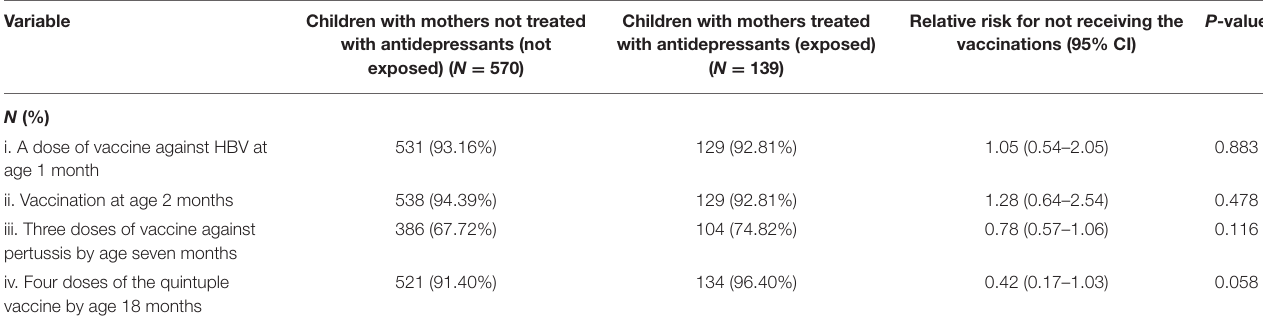
TABLE 4 | Relative risk values for non-vaccination of children whose mothers had pospartum depression symptoms who were treated with antidepressants in comparison with children whose mothers had postpartum depression symptoms who were not treated with antidepressants. P Relative risk for not receiving the Children with mothers treated Variable Children with mothers not treated vaccinations (95% CI) with antidepressants (exposed) with antidepressants (not ( N = 139) exposed) ( N = 570)